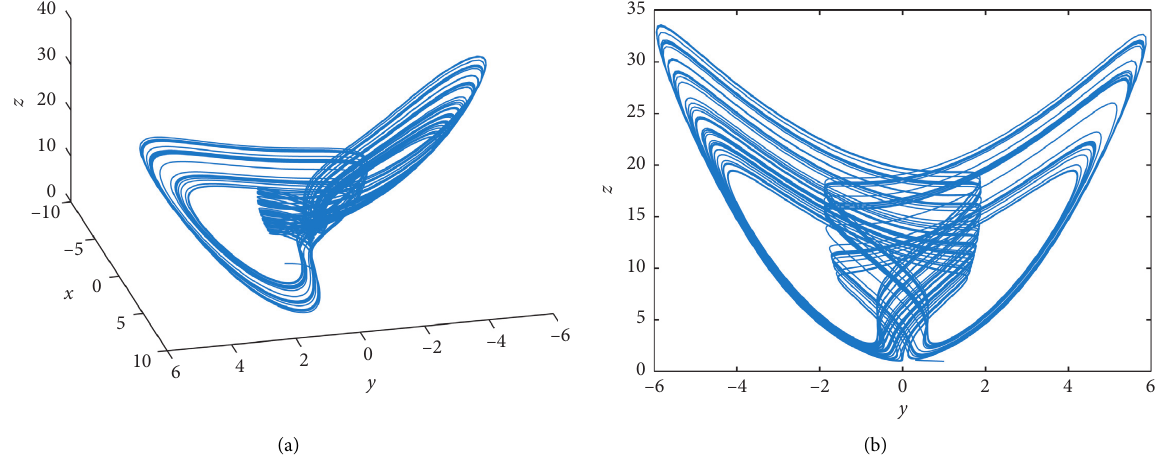
Figure 10: Phase portraits of the fractional system with a � 3 . 5 and α � 0 .